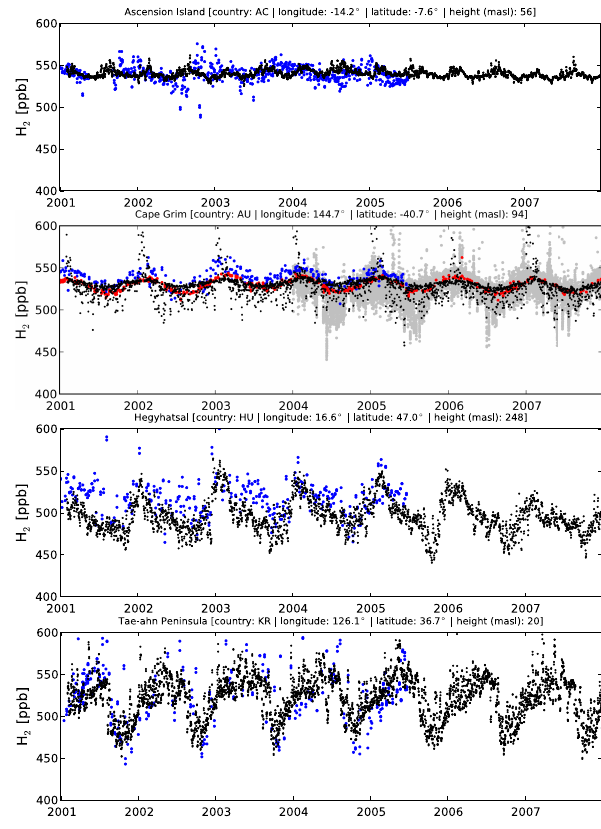
Fig. 1. Comparison between the measured background and mod- elled (black) noon-time H 2 mixing ratios at Alert, the South Pole, Barrow and Mace Head. Available measurements from NOAA, CSIRO and AGAGE are shown in blue, red, and grey, respectively. Measurements from AGAGE are shown without filtering for back- ground conditions.